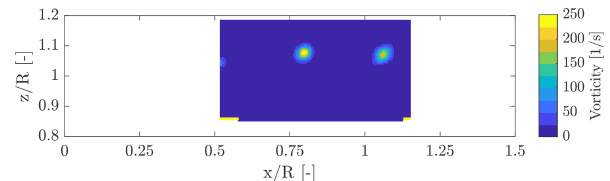
Figure 14. Vorticity for the RATED2 operating condition without surge motion. x/R and z/R are the axial and vertical distance from the rotor apex normalized by rotor radius. The origin of the axes is coincident with the rotor apex when the wind turbine is in the zero-surge position (see the Results ref. frame of Fig.